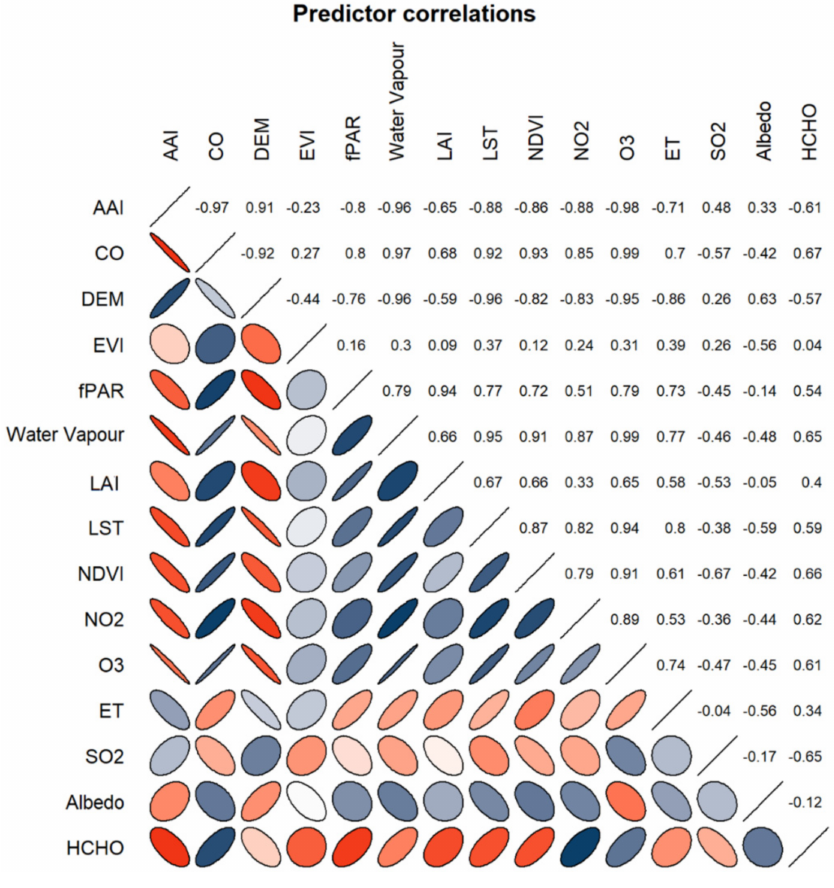
Figure 6. Square correlation matrix between input